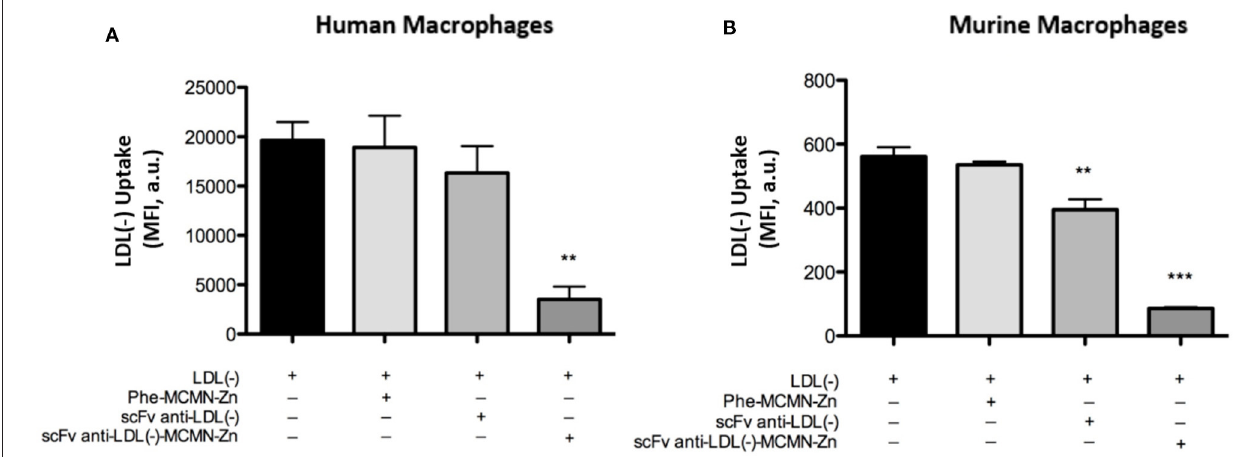
FIGURE 4 | Effects of the scFv-anti-LDL(-)-MCMN-Zn nanoformulation on LDL(-) uptake by human and murine primary macrophages. Flow cytometry measurements data from (A) human and (B) murine macrophages treated with 10 4 particles/mL of scFv-anti-LDL(-)-MCMN-Zn nanoformulation (containing 6.25 µ g/mL of scFv) of scFv-anti-LDL(-)-MCMN-Zn nanoformulation and 37.5 µ g/mL of LDL(-) individually or combined for 3h. LDL(-) was fluorophore DiI(C 18 )-labeled. Data from three independent experiments, performed in triplicate, are expressed as the means ± SD; ** p < 0.01 *** p < 0.001 compared with LDL(-); ANOVA followed by the Tukey-Kramer‘s test.